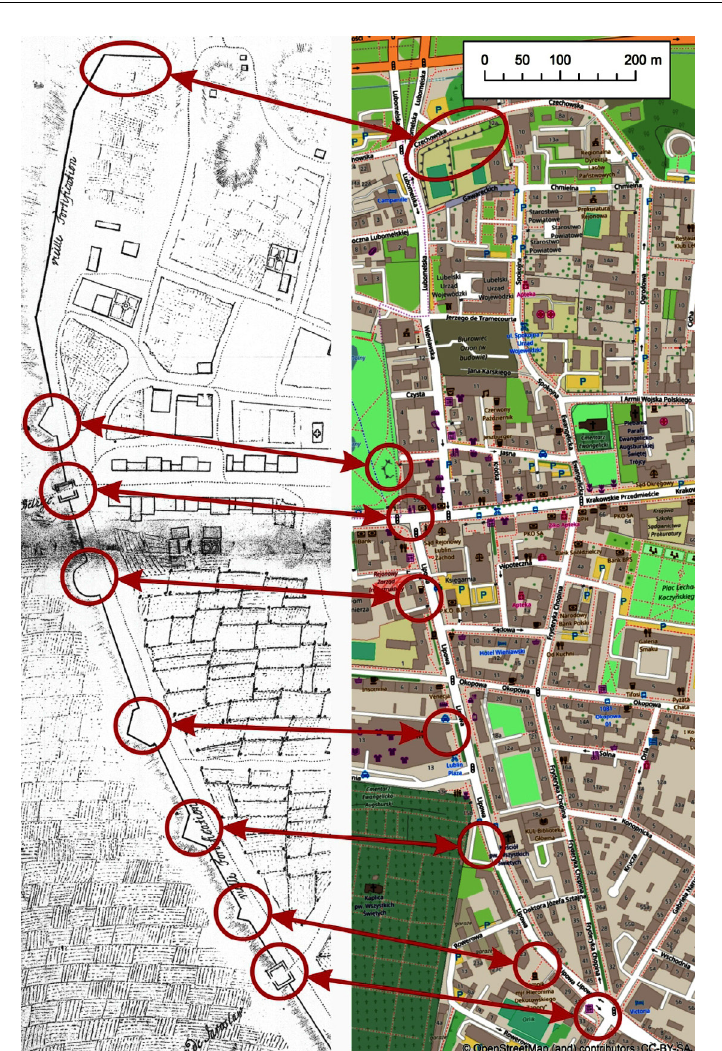
Fig. 7. Works of the fourth line of fortifications as depicted on d’Örken’s map and the contemporary